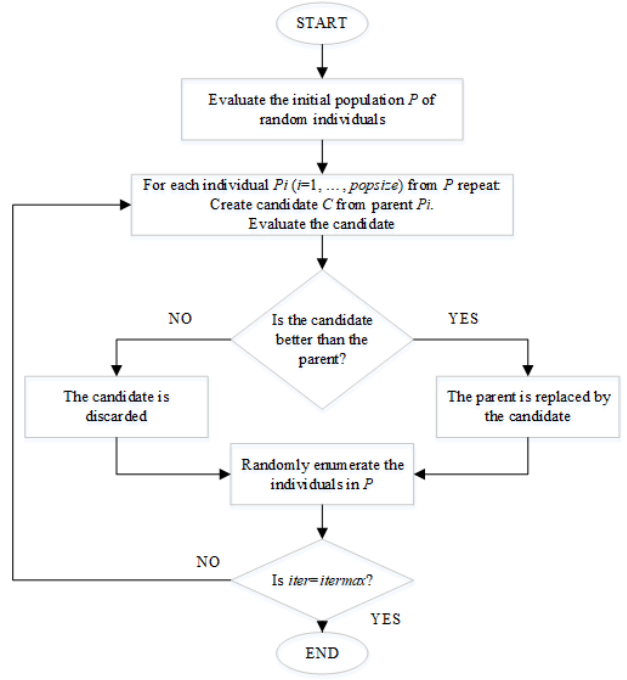
ff erential evolution (DE) optimization applied Figure 2. Flowchart of the differential evolution (DE) optimization applied [24]. Figure 2. Flowchart of the di